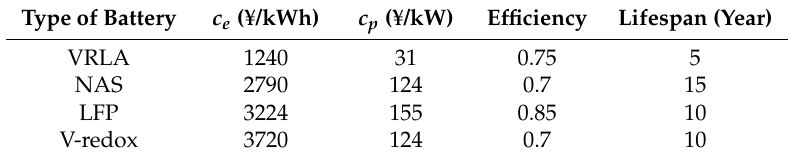
Table 1. Parameter of batter energy storage. VRLA: Valve regulated lead acid, LFP: LiFePO4, V-redox: Vanadium Redox.